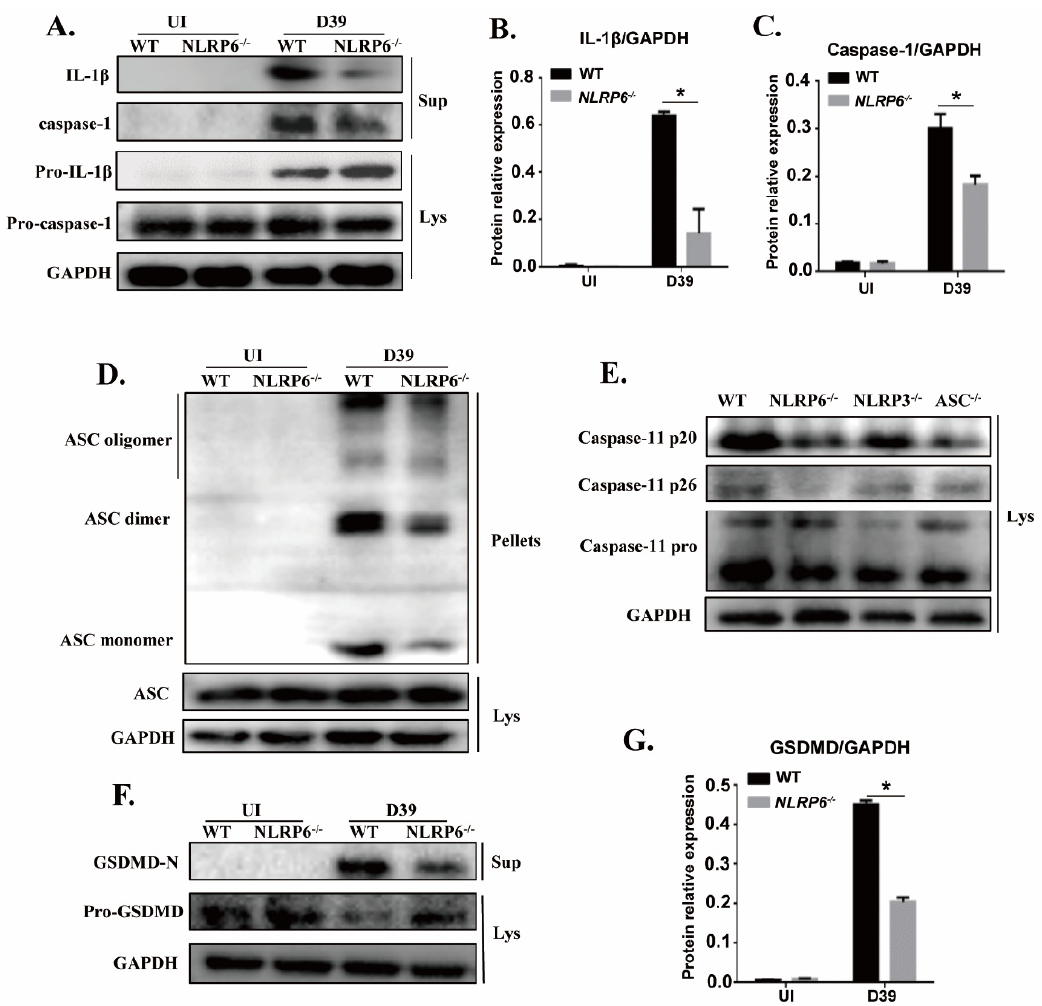
Figure 3. NLRP6 inflammasome mediates activation of caspase-1 and caspase-11 in S. pneumoniae -infected macrophages. The culture supernatant (Sup) and the cell lysate (Lys) in S. pneumoniae -infected macrophages of WT and NLRP6 − / − mice were collected at 24 h post infection. Western blotting analysis was used to detect the formation of caspase-1 (p20: subunit; p45: precursor) ( A ), caspase-11 ( E ), and GSDMD ( F ). Immunoblotting was used to analyze the formation of ASC ( D ). Ratio of IL-1 β ( B ), caspase-1 ( C ), and GSDMD-N ( G ) levels against GAPDH levels was quantified. Statistical significance was determined by Student’s t -test. (* p < 0.05).